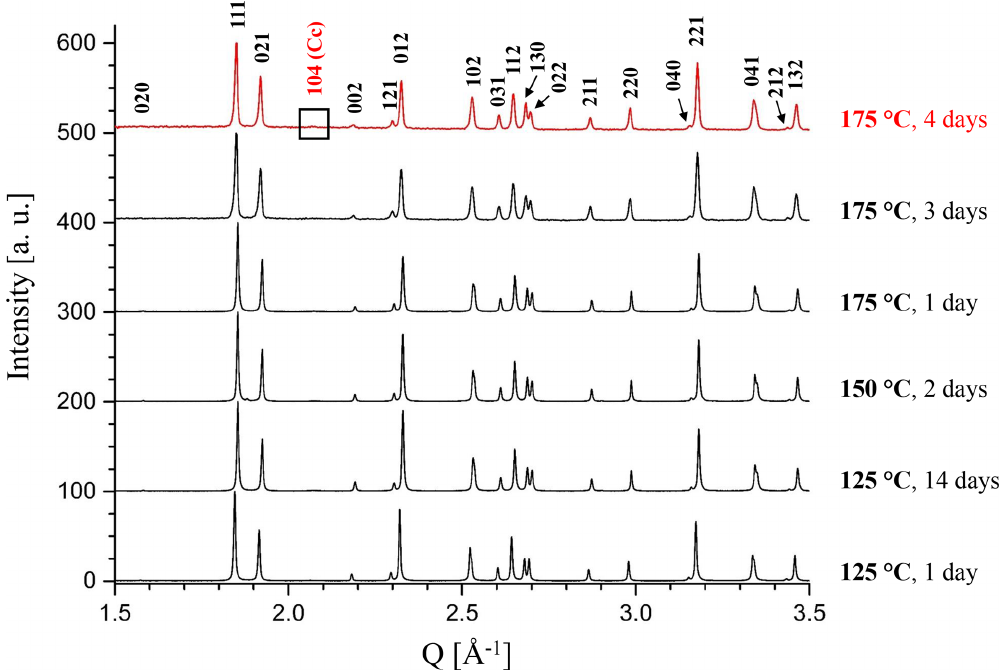
Figure A11. XRD measurements of experimentally altered Arctica islandica samples subjected to alteration temperatures between 125 and 175 ◦ C for various lengths of time (1, 2, 3, 4 and 14 days). Calcite formation starts at 175 ◦ C and an alteration time of 4 days. Miller indices for calcite (Cc) are given in red and those for aragonite in